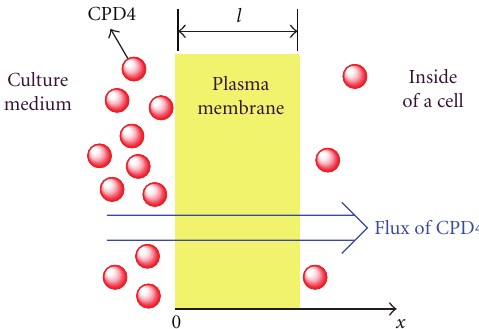
Figure 3: Cartoon illustrating the di ff usion of CPD4 from culture medium to the inside of a